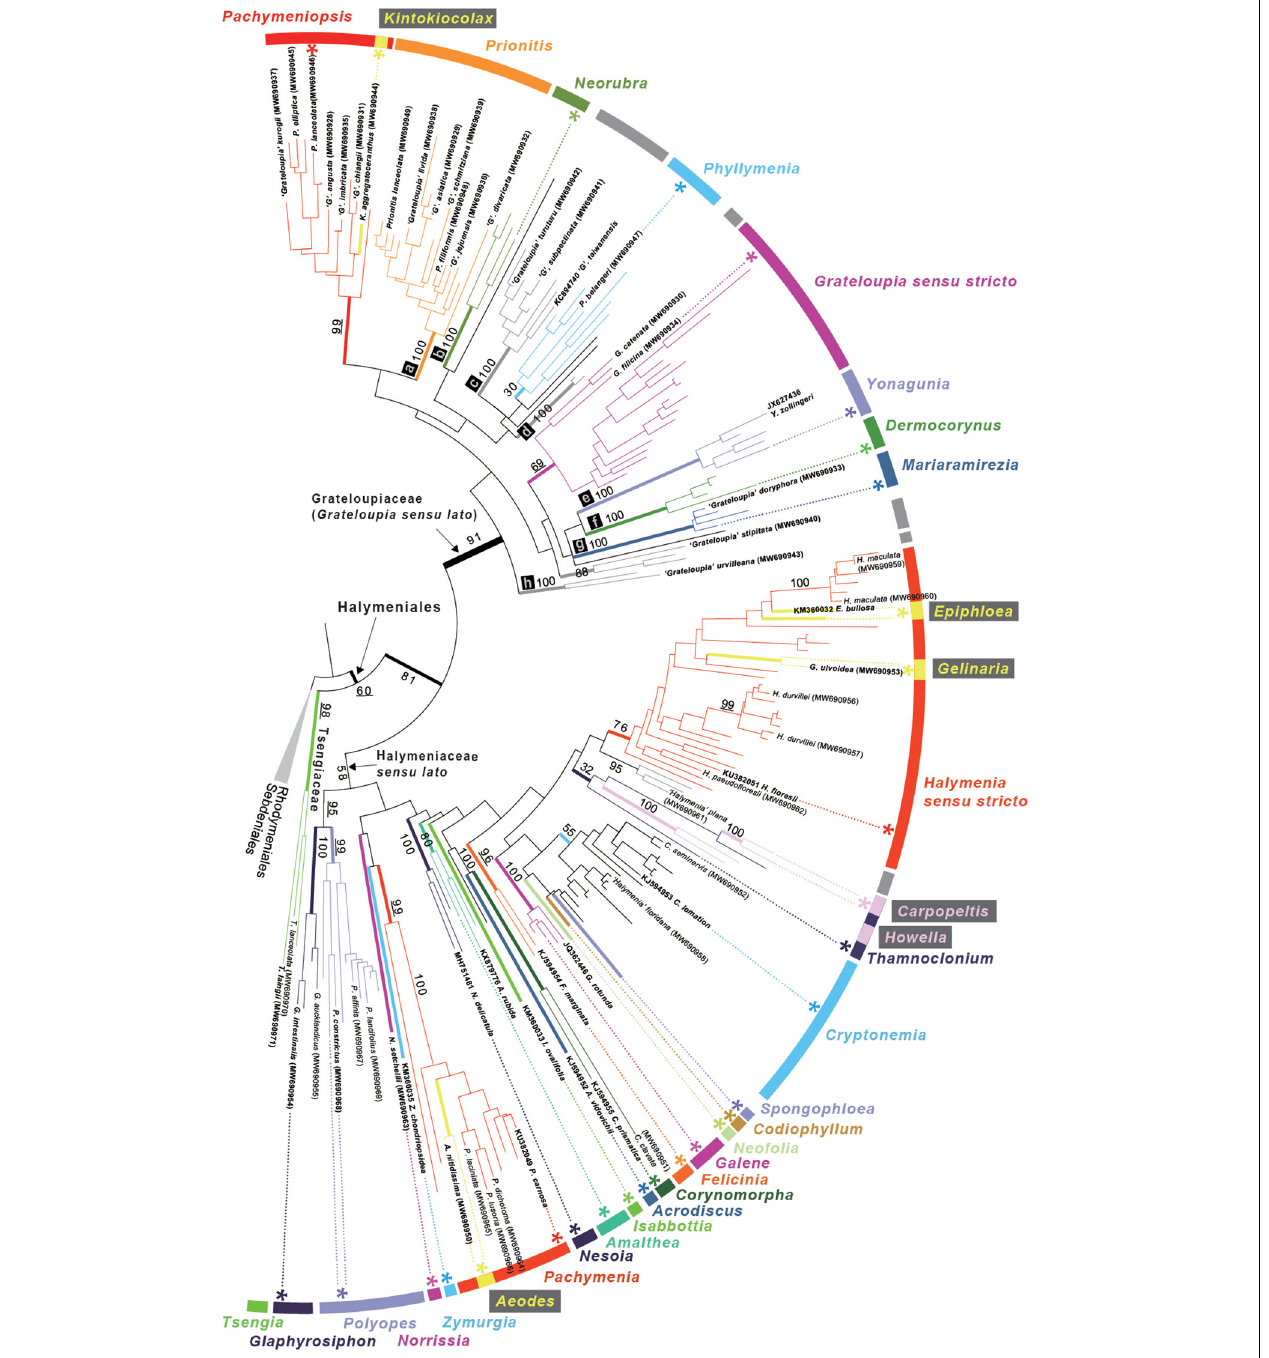
FIGURE 2 | ML phylogeny of the Halymeniales using rbc L. Maximum Likelihood (ML) phylogeny of Halymeniales inferred from 207 rbc L sequences. The tips with GenBank accessions in parentheses indicate newly analyzed rbc L sequences in this study. Bolded taxa indicate the species selected for 5-gene analyses. Numbers at bold nodes correspond to bootstrap support for some important nodes. Asterisk (*) indicates type species of each genus. Labeled tree with all taxon names and bootstrap support is shown in Supplementary Figure 1 .